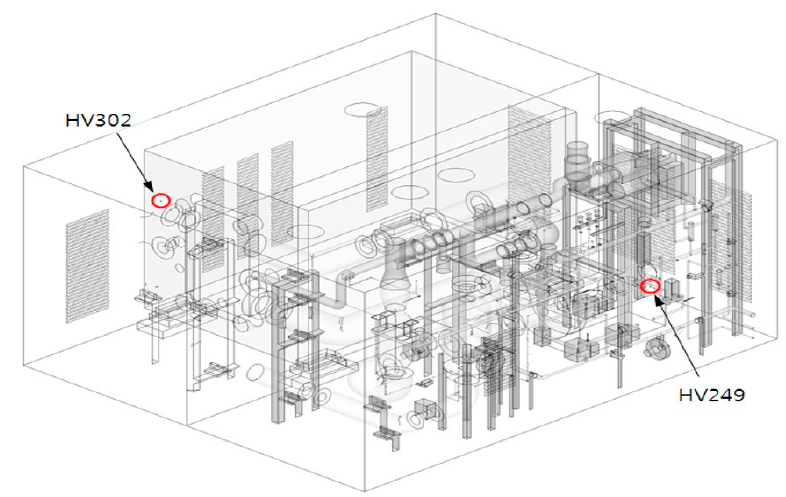
Figure 3. Conditions of the inlet and outlet of the balance-of-plant (BOP) package: ( a ) louver installation locations (inlet) and ( b ) exhaust pipe locations (outlet).